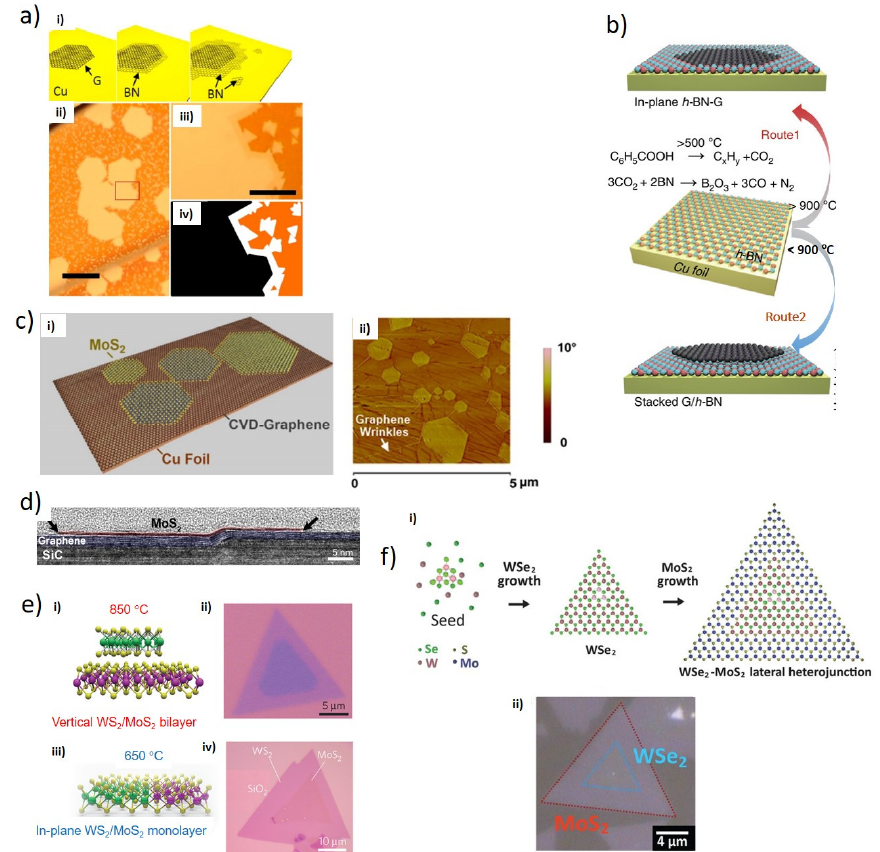
Figure 4. ( a ) Schematic of the continuous growth of graphene/hexagonal boron nitride (h-BN) heterostructures on Cu foil (i). Low (scale bar is 50 µm) (ii) and high magnification (scale bar is 10 µm) (iii) image of graphene/h-BN heterostructures on oxidized Cu substrate; (iv) false color image. Black, white and brown regions indicate graphene, h-BN and bare Cu regions in panel (iii), respectively [92]; ( b ) Schematic illustration of the temperature-triggered switching growth between in-plane and vertical graphene/h-BN heterostructures, depicted by Route 1 and Route 2, respectively [93]; ( c ) Schematic of hexagonal MoS 2 layers grown on a CVD graphene template (i). AFM phase image of MoS 2 grains on graphene (ii) [94]; ( d ) Cross-sectional high resolution TEM of MoS 2 layer grown on epitaxial graphene [95]; ( e ) Schematic and optical image of the vertically-stacked heterostructure synthesized at 850 °C (i, ii) and lateral WS 2 /MoS 2 heterostructure synthesized at 650 °C (iii, iv) [96]; ( f ) Schematic illustration of the sequential growth of the monolayer in-plane WSe 2 /MoS 2 heterostructures (i) and optical micrograph of the heterostructures depicting the contrast between two layers [97]. Reproduced with permission from: (a) [92] copyright © 2013 American Chemical Society; (b) [93] copyright © 2015 Macmillan Publishers Ltd.; (c) [94] copyright © 2012